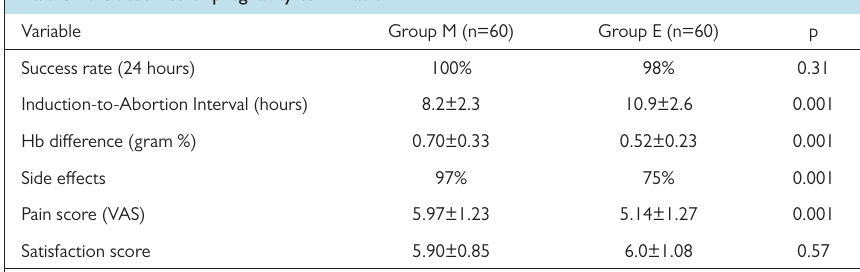
Table 2. Outcomes of pregnancy